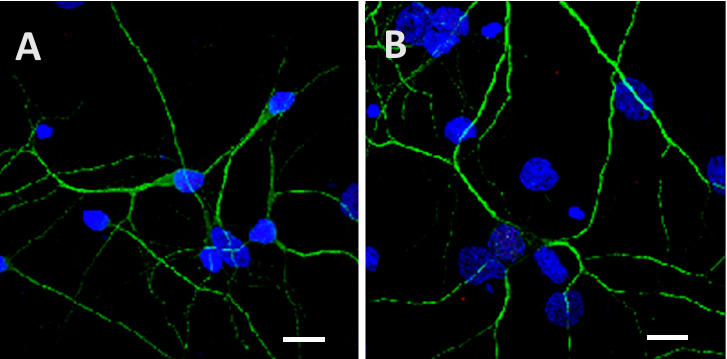
Figure A5. Low phosphorylated (15 µ g; A ) and highly phosphorylated Tau proteins (1.5 µ g; B ) were no longer observed inside cortical cells after an incubation of 8 h followed by a washing for 24 h with medium. Scale bars, 10 μ m.